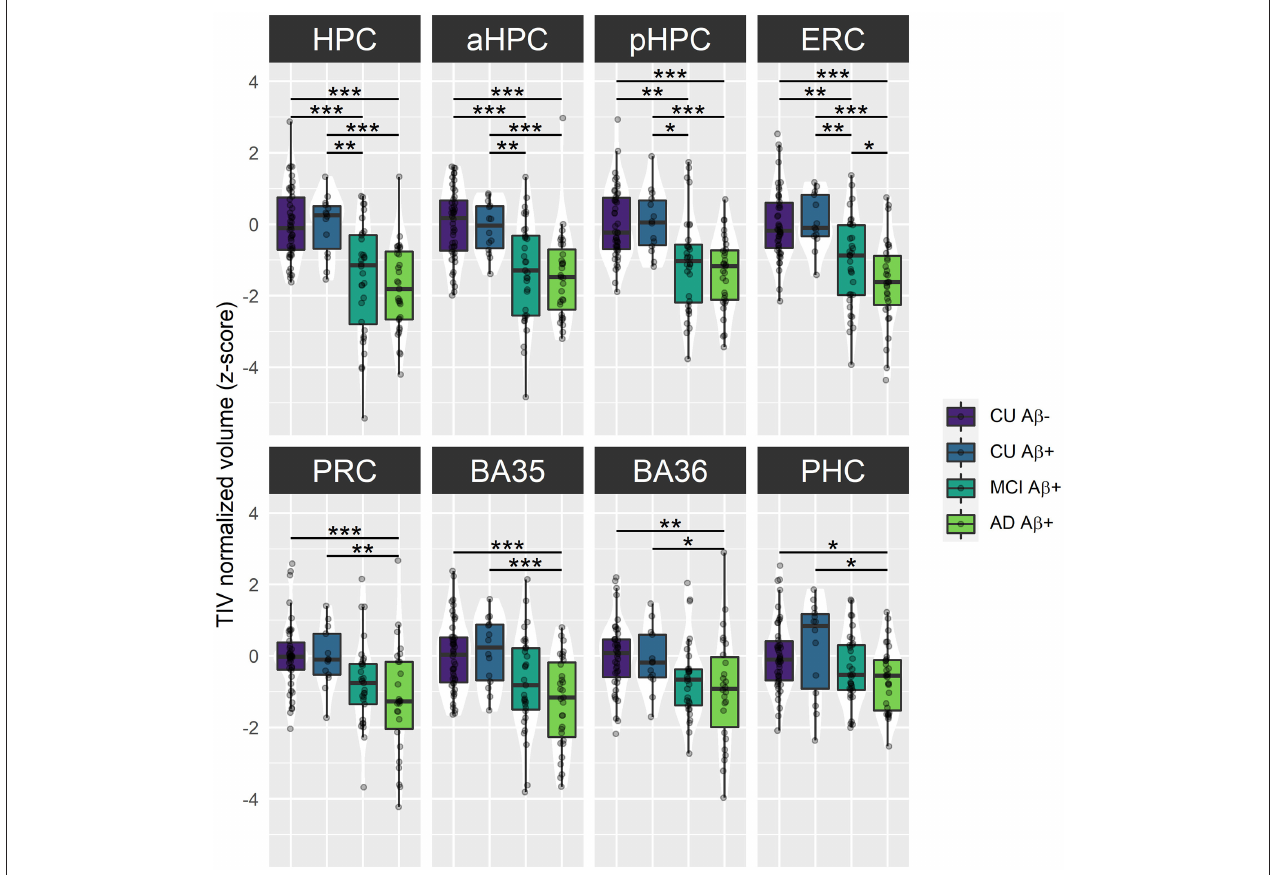
FIGURE 2 | Group comparisons of MTL subregions baseline volume across the Alzheimer’s continuum. Boxplots display the median values and distribution of z-transformed TIV normalized volumes at baseline in each group. *** p < 0.001; ** p < 0.01; * p < 0.05, as results of Tukey adjusted post-hoc t -tests. AD, Alzheimer’s dementia; BA, Brodmann area; CU, cognitively unimpaired; ERC, entorhinal cortex; HPC, hippocampus (a, anterior; p, posterior); MCI, mild cognitive impairment; PHC, parahippocampal cortex; PRC, perirhinal cortex. The corresponding statistics are depicted in Supplementary Table 5